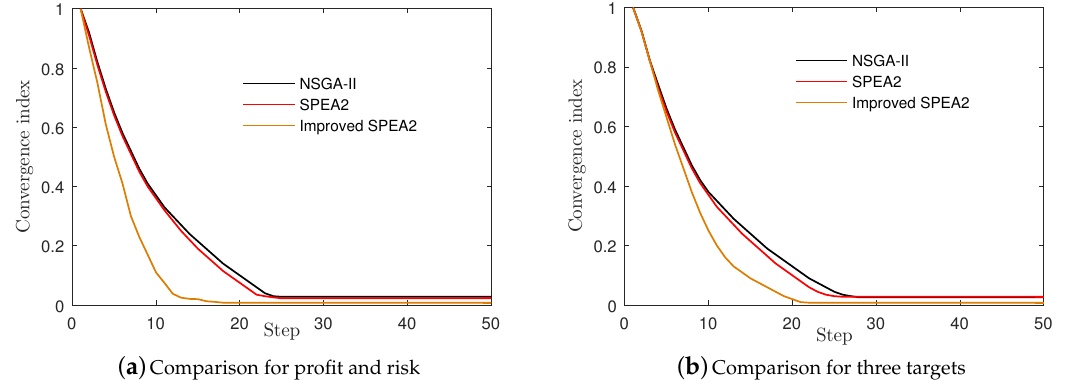
Figure 7. Mean convergence comparison of 300